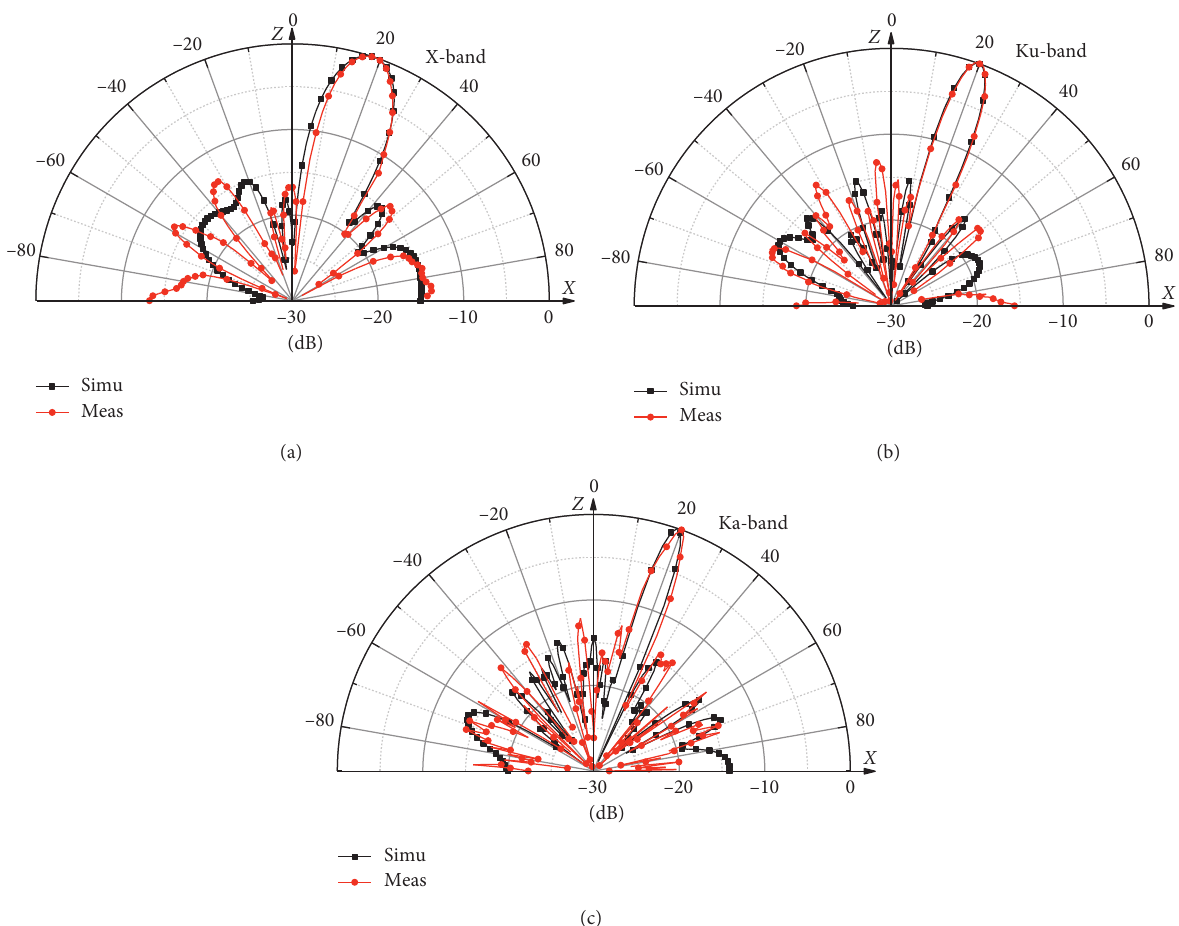
Figure 21: The normalized radiation pattern measured and simulated results of FRAA prototypes in different frequency reconstruction states. (a) X-band. (b) Ku-band. (c)